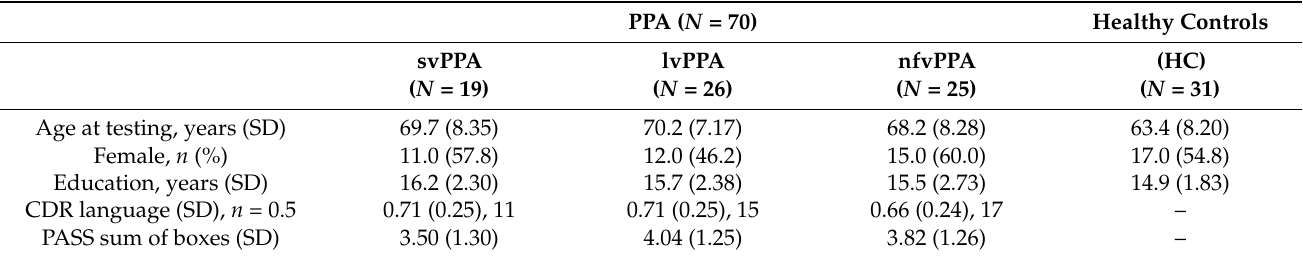
Table 1. Summary demographic information and clinical characteristics for the participants included in this study (see Appendix A Table A1 for participant-specific